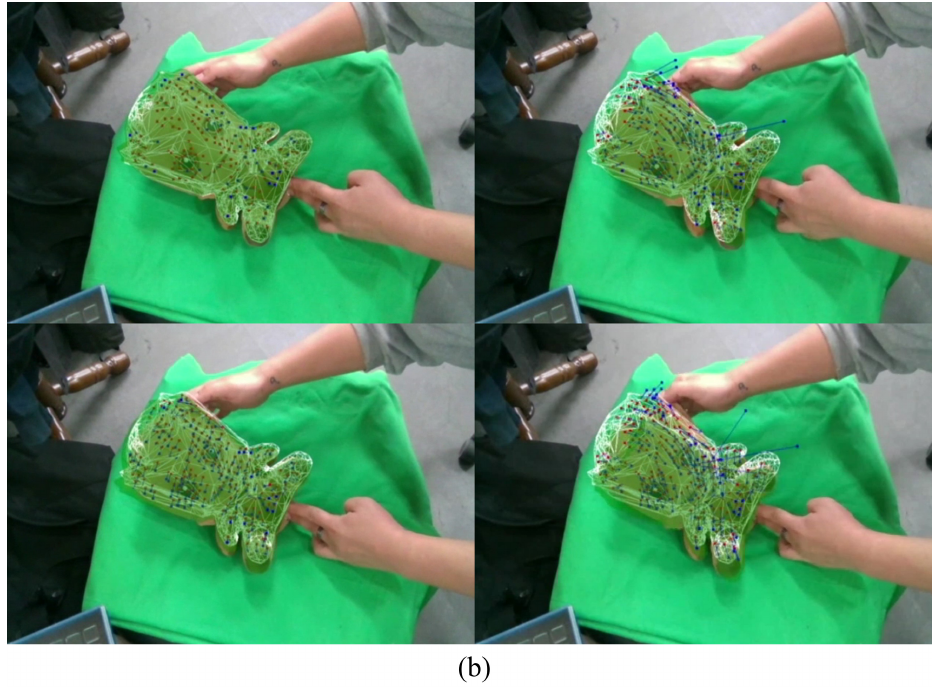
Figure 9. Deformation of ( a ) a cuboid sponge and ( b ) plush doll: The high-resolution model (green) was deformed by tracking the feature vectors (blue) of the feature points (red) for every frame. Table 2. Computation time (Init.: initialization, Sim.: simulation). Model Sponge Doll Time (ms) Init. Sim. Init. Sim. Feature-Point